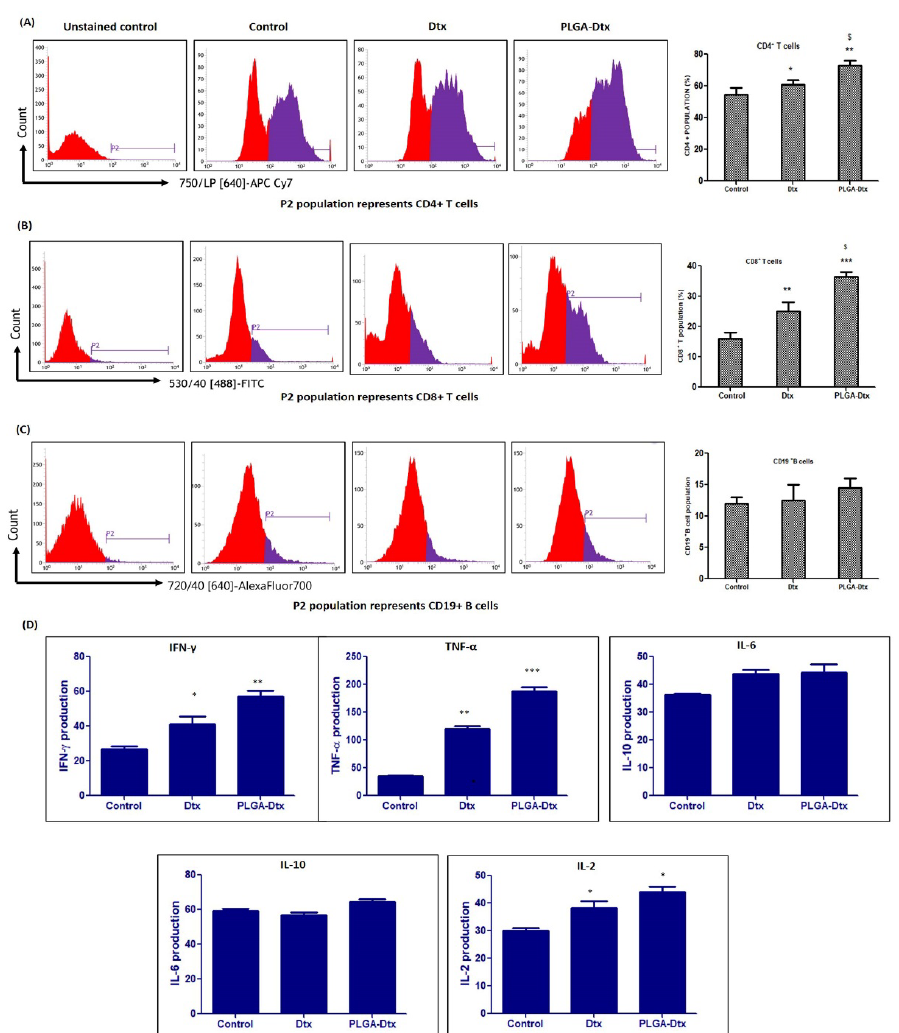
Figure 6. Flow cytometric analysis of effect of Dtx and PLGA-Dtx on the relative distribution of T lymphocyte (CD4+/CD8+) and B lymphocyte (CD19+) populations in Con A (T cell activation) and LPS (B cells activation) stimulated peripheral blood mononuclear cells. PBMCs were treated with non-cytotoxic concentration of PLGA-Dtx derived from MTT assay for 72 h. ( A ) Histogram showing the CD4+ T lymphocytes cells; ( B ) histogram showing the CD8+ T lymphocytes cells; ( C ) histogram showing the CD19+ B lymphocytes cells; ( D ) effect of Dtx and PLGA-Dtx in supernatant of PBMCs treated with Dtx and PLGA-Dtx for 24 h. Data were the mean ± SEM from at least three independent experiments. (* p < 0.05, ** p < 0.01, and *** p < 0.001 compared with the control group), ($ p < 0.05 compared with the free